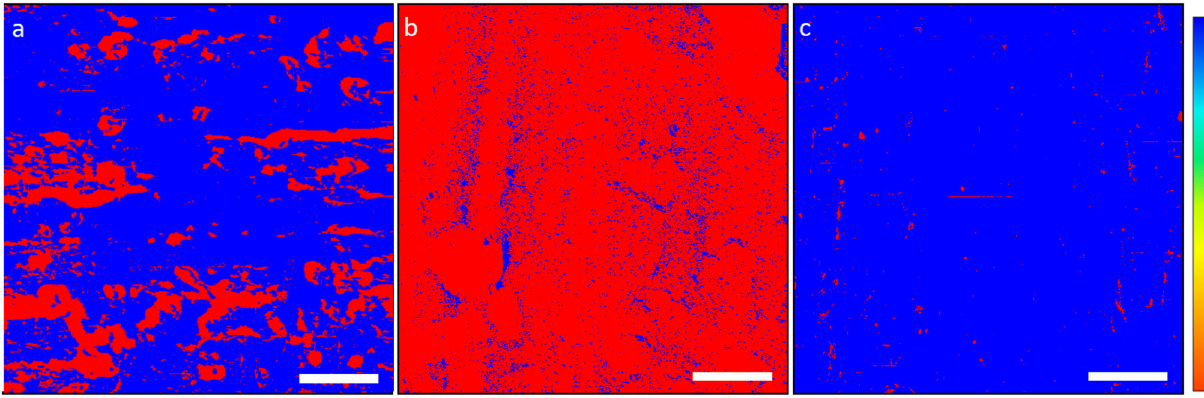
Fig. 3 Conductivity maps at 8 V applied bias for samples. a 10C-1.5O, b 10C-12O, and c ECCS. The scale bars in a , b , and c indicate 10 μ